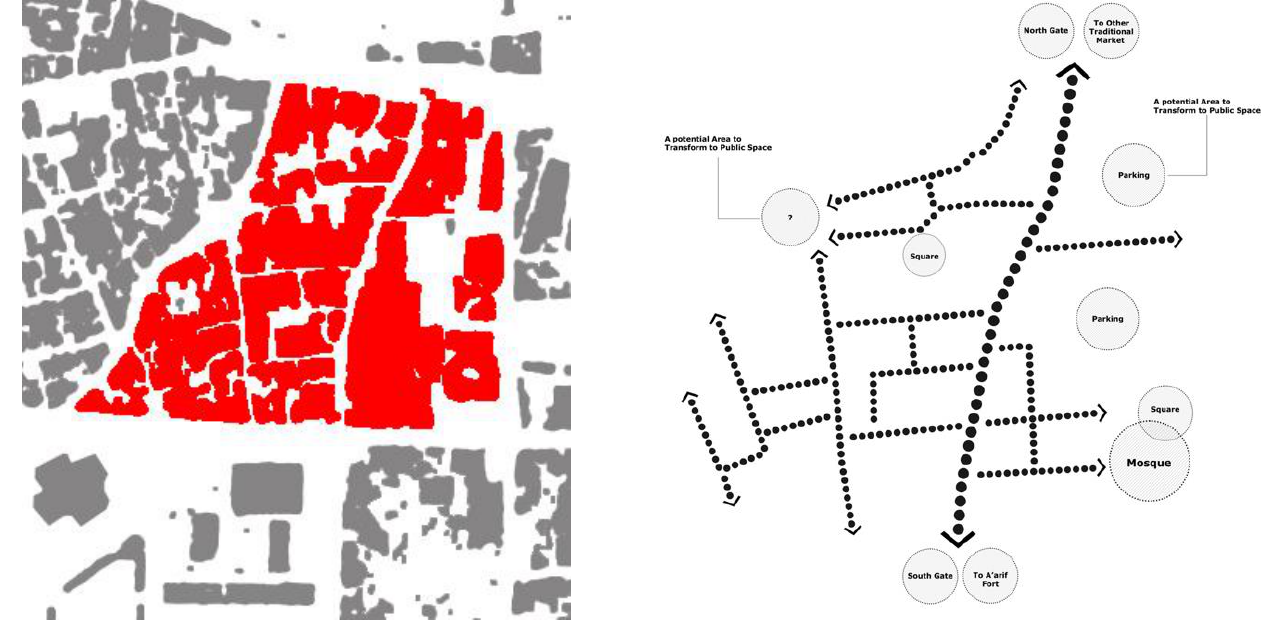
Figure 9. Spatial analysis of Barzan Market. Source: Authors.